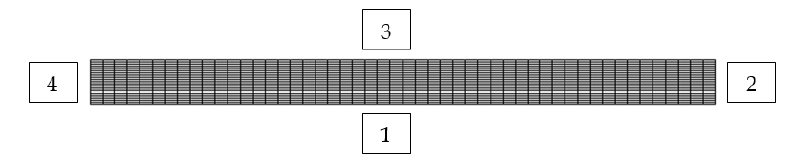
Figure 15. Numerical mesh for 2D domain (50 × 20 CV).